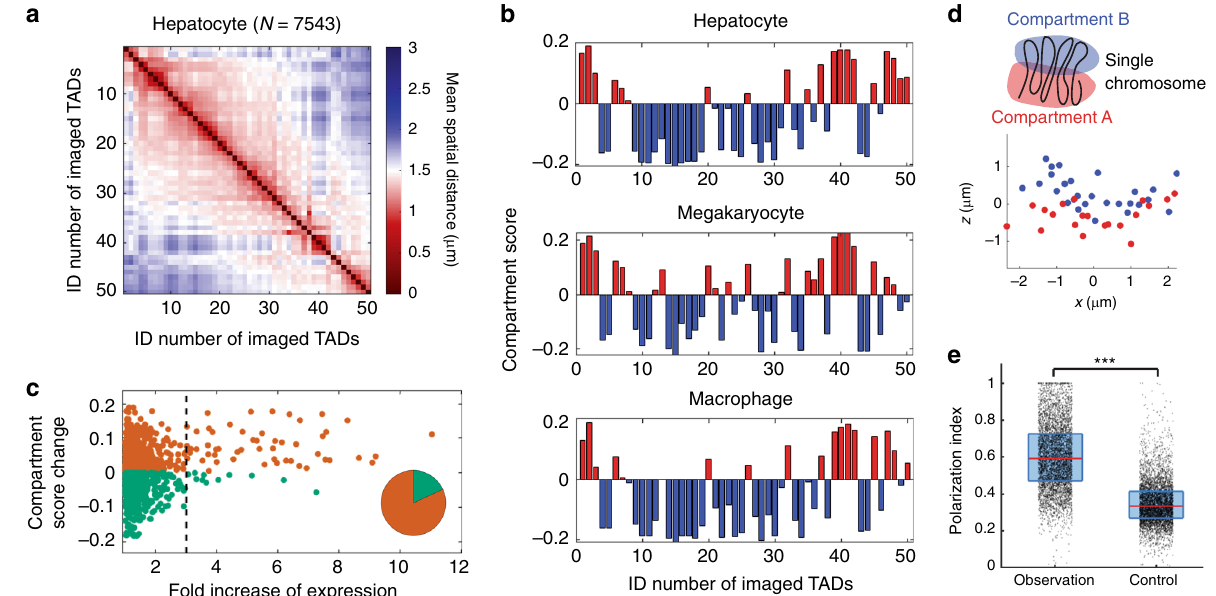
Fig. 3 Cell-type-speci fi c chromatin folding at the TAD-to-chromosome length scale. a Mean spatial distance matrix of the 50 TADs in hepatocytes. b Compartment scores of the 50 TADs in three cell types. c Fold increase of RNA copy number for each gene between each pair of cell types versus the change of compartment score of the gene region between the pair of cell types. Pie chart: Counts of data points with more than three-fold increase of expression. Orange: increase of compartment score. Green: decrease of compartment score. d (Top panel) Schematic illustration of the concept of compartment polarization. (Bottom panel) Spatial positions of compartment-B TADs (blue dots) and compartment-A TADs (red dots) in a copy of Chr19. The chromosome was rotated in space for better visualization of the polarized organization of A/B compartments. e Polarization indices of individual chromosomes in proerythroblasts. Observed values were compared with a randomization control, where we randomized the compartment assignments of TADs while maintaining the number of TADs in each compartment. Each dot corresponds to a single copy of Chr19. Data from 4830 chromosomes were used to generate each observation and control group in e . The red lines represent medians. The boxes show the 25% and 75% quantiles. *** p < 10 − 307 (two-sided Wilcoxon rank sum test; the exact p value is smaller than the smallest positive double precision fl oating-point number in MATLAB). Observation minimum, 25% quantile, median, 75% quantile, and maximum equal 0.02, 0.47, 0.59, 0.73, and 1, respectively. Control minimum, 25% quantile, median, 75% quantile, and maximum equal to 0.01, 0.27, 0.33, 0.41, and 1 respectively. Source data are provided as a Source data fi